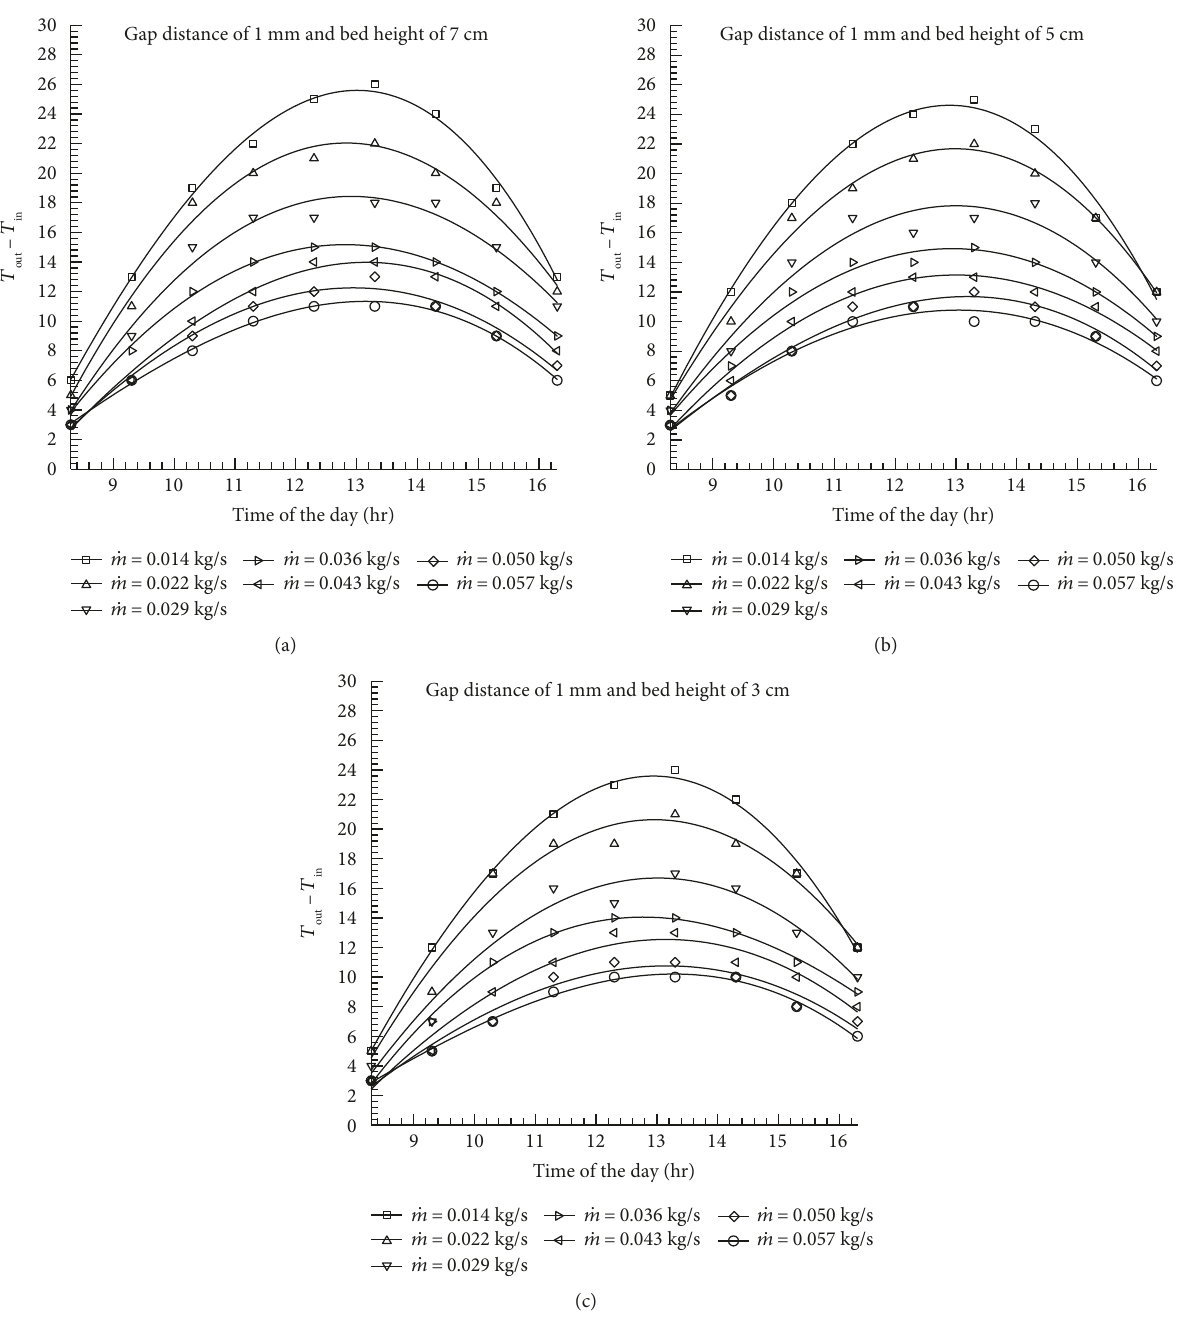
− T out in ) versus time at a gap distance of 1 mm for di